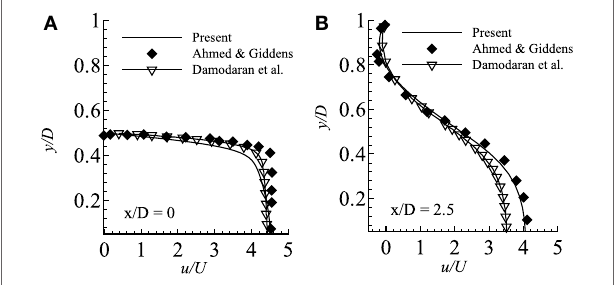
FIGURE 2 | Comparison of streamwise velocity in two different axial locations (A) x / D = 0.0 and (B) x / D = 2.5 considering axisymmetric wall condition and compared with the experimental results of Ahmed and Giddens (1983) and numerical results of Damodaran et al. (1996) while Re = 500 and 75% stenosed